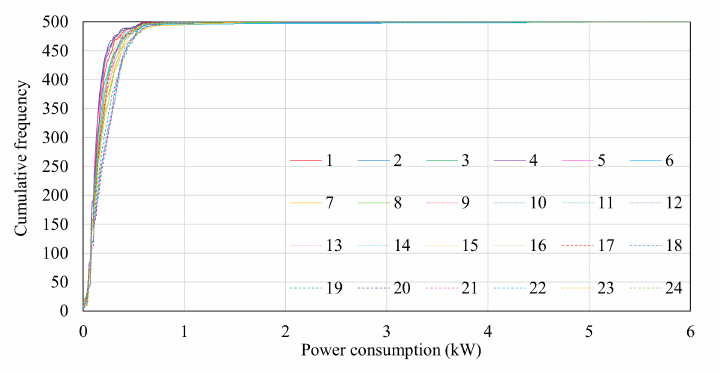
Figure 4. Hourly cumulative frequency distributions in the day of the lowest electricity